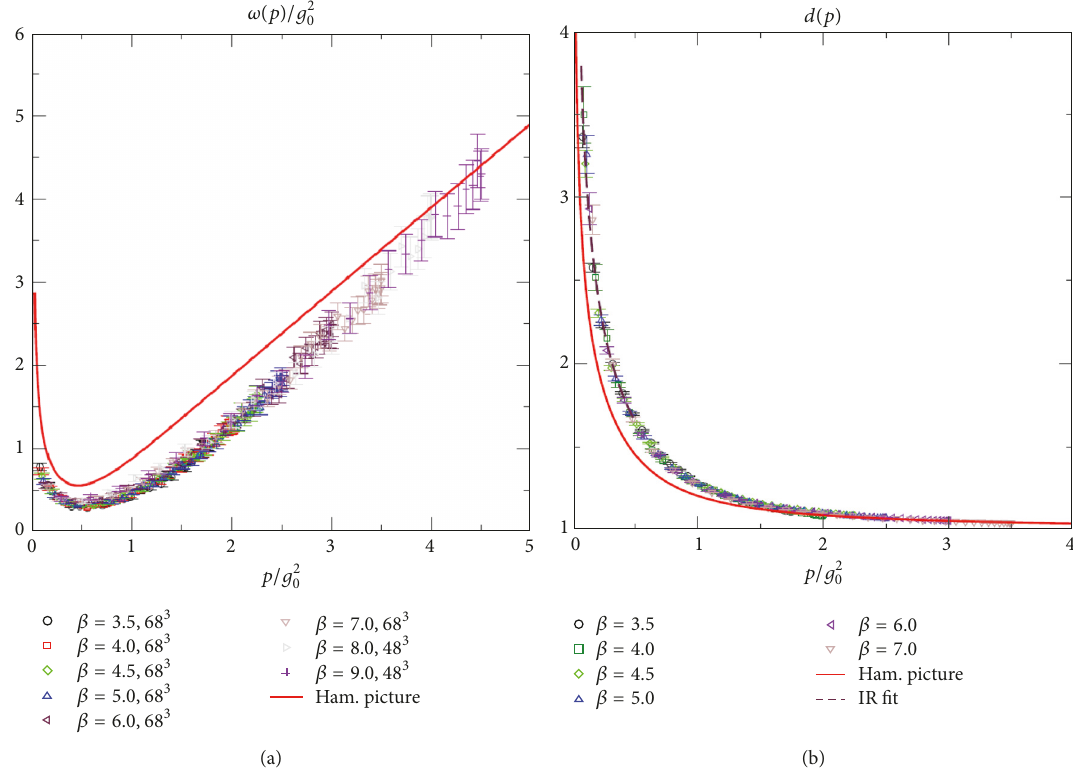
Figure 4: Comparison of the variational approach to (2 + 1) -dimensional Yang–Mills theory in Coulomb gauge [27] with the lattice data [28]: (a) gluon energy and (b) ghost form